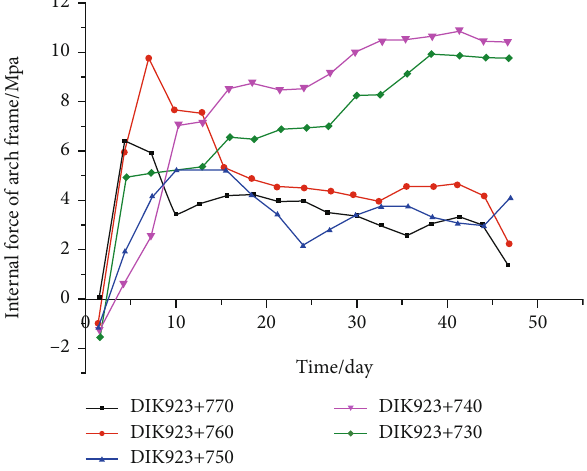
Figure 13: Internal force curve of steel